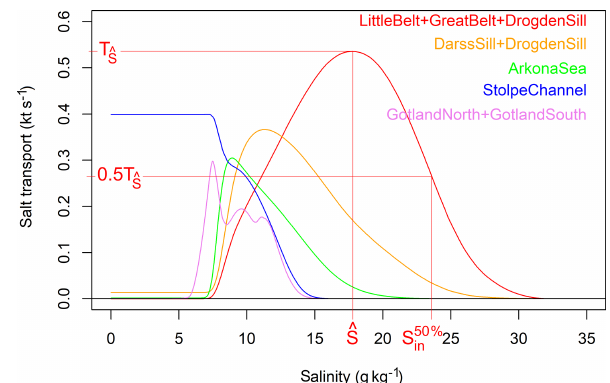
Figure 2. Net salt transports into the Baltic Sea above a specific salinity level, temporal average across the simulation period 1850– 2008. Horizontal and vertical lines visualize how the threshold salinity S 50% for discriminating between the import of high-salinity in and low-salinity water is